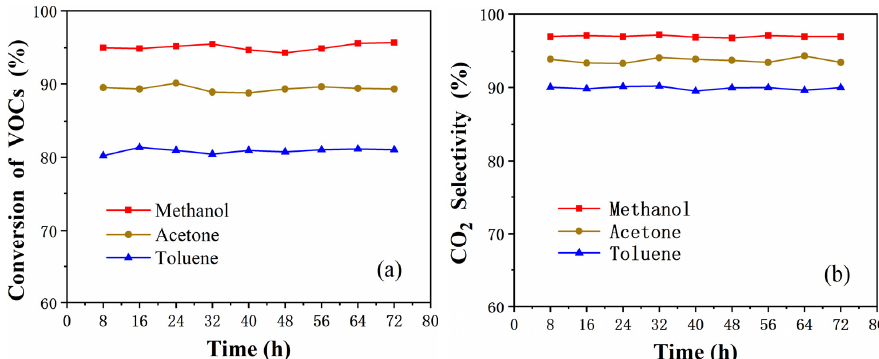
Figure 12. Continuous stability test of ( a ) VOCs conversion and ( b ) CO 2 selectivity on Mn/ZSM-5-N during 72 h at the initial concentration of 3,000 ppm and SIE of 9 kJ/L.